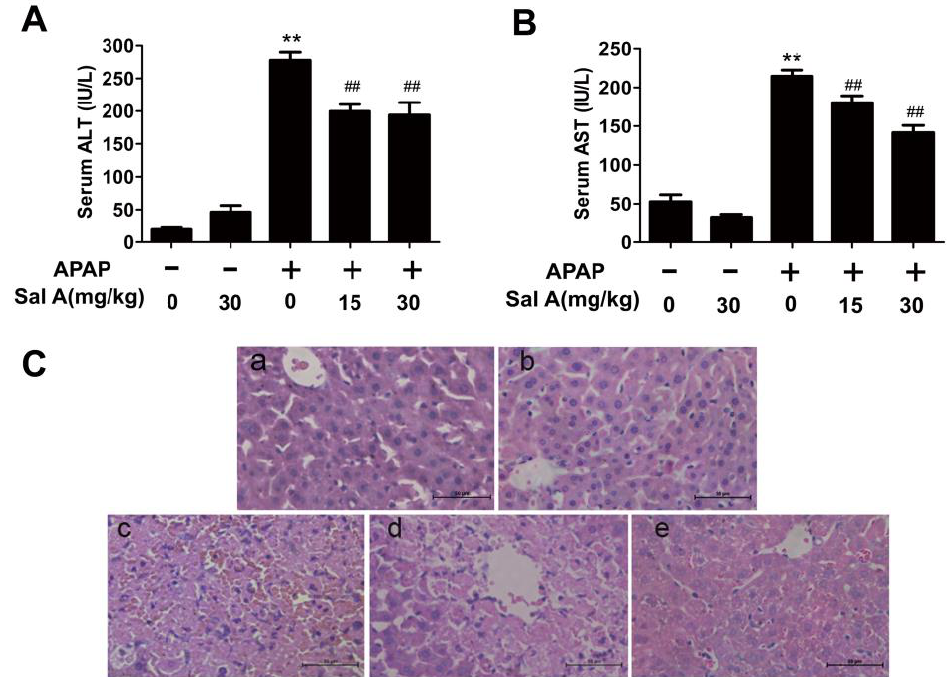
Figure 1. Sal A attenuates liver injury induced by APAP in mice. ( A , B ) Serum levels of ALT and AST, n = 8. ( C ) H&E staining (200 × magnification): a. control; b. Sal A (30 mg/kg); c. APAP (300 n = 8. ( C ) H&E staining (200× magnification): a. control; b. Sal A (30 mg/kg); c. APAP (300 mg/kg); d. APAP+Sal A (15 mg/kg); e. APAP+Sal A (30 mg/kg). ** p < 0.01 vs. control group, ## p < 0.01 vs. APAP group.